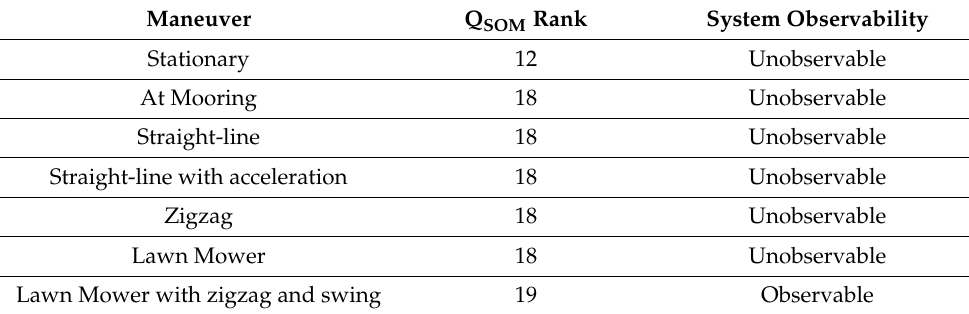
Table 1. Observability and final rank of Q SOM ( j = 100). INS/GPS/DVL/PS integration. Maneuver Q SOM Rank